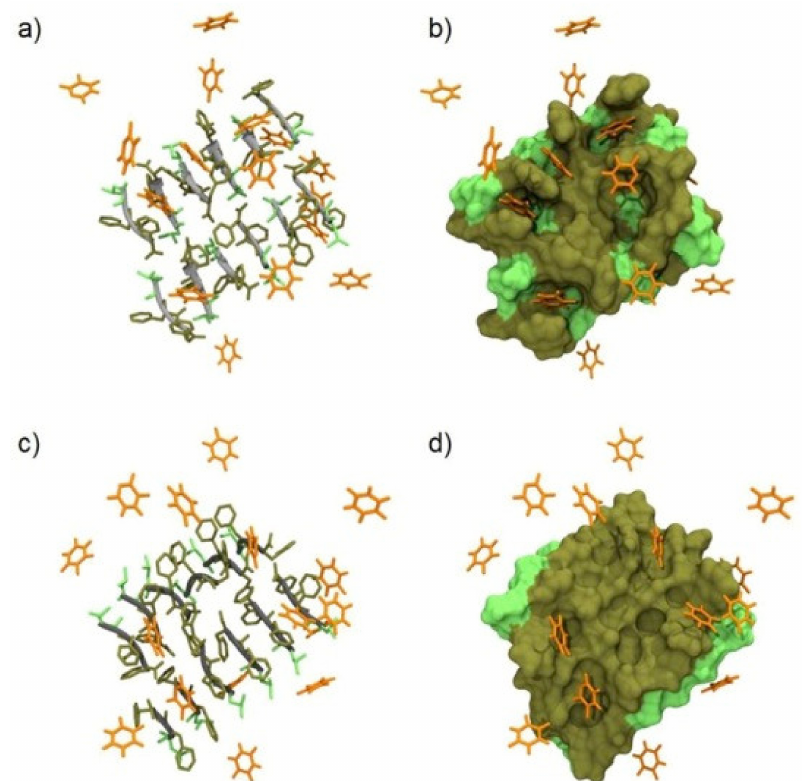
Figure 5. All-atom molecular dynamics snapshots ( left ) and molecular surface ( right ) of D Leu- L Phe- L Phe stacks (gray/green) with 5-fluoruracil (orange). ( a , b ) and ( c , d ) images refer to antiparallel and parallel β -sheet conformations, respectively. Leu-side chains are depicted in light green, and Phe-side chains are depicted in dark green, respectively. Water and ions are omitted for clarity. Reproduced